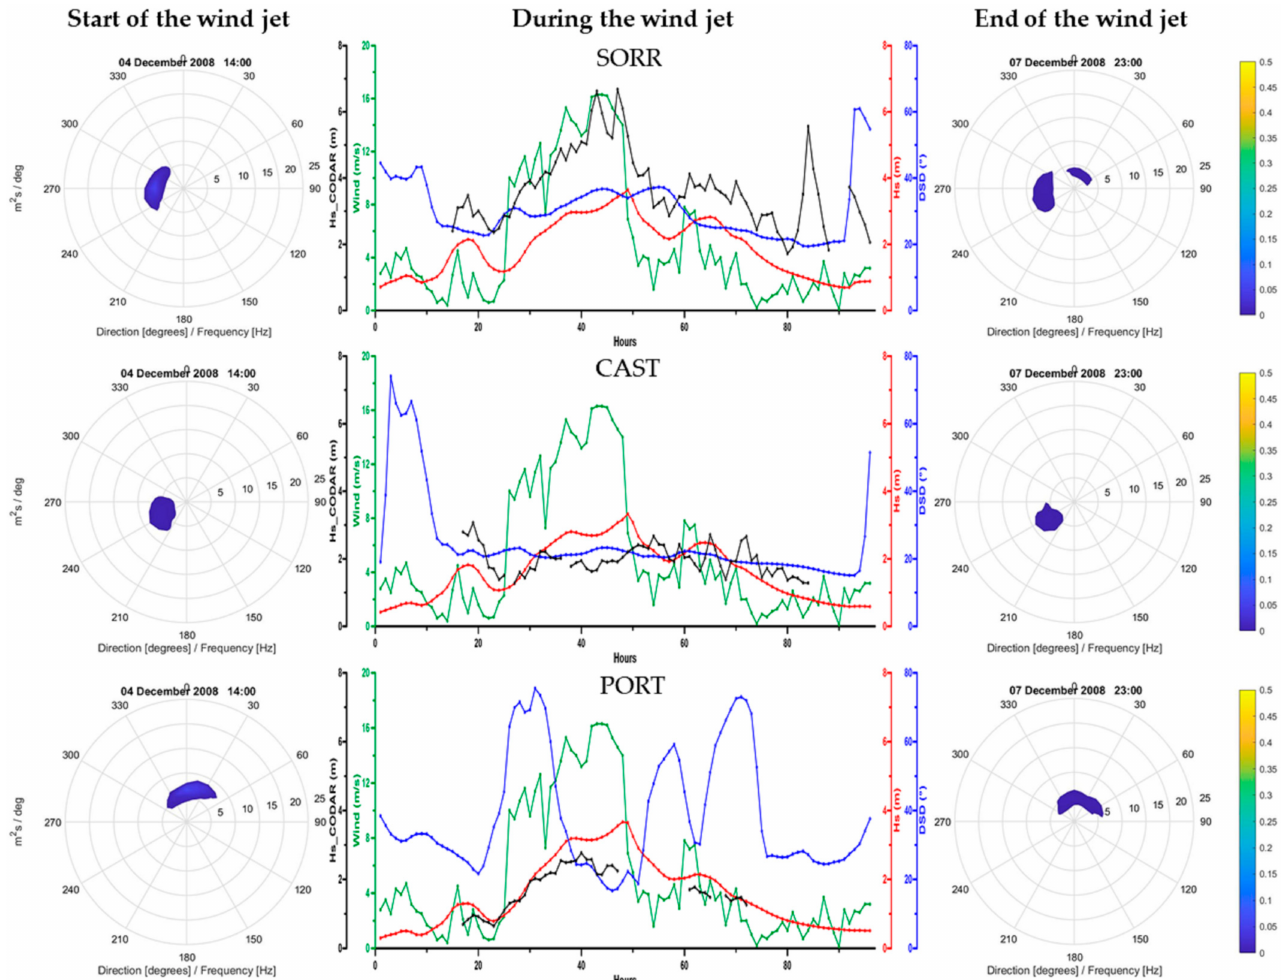
Figure 6. Evolution of the storm event recorded on 4–7 December 2008. The first and third panels show the model spectral energy as the wind jet started and finished, respectively. The central panels illustrate the evolution, during the event, of the wind intensity (in green), significant wave height (of the model Hs m (in red) and retrieved by the HFr Hs HF (in black)) and directional spreading DSD